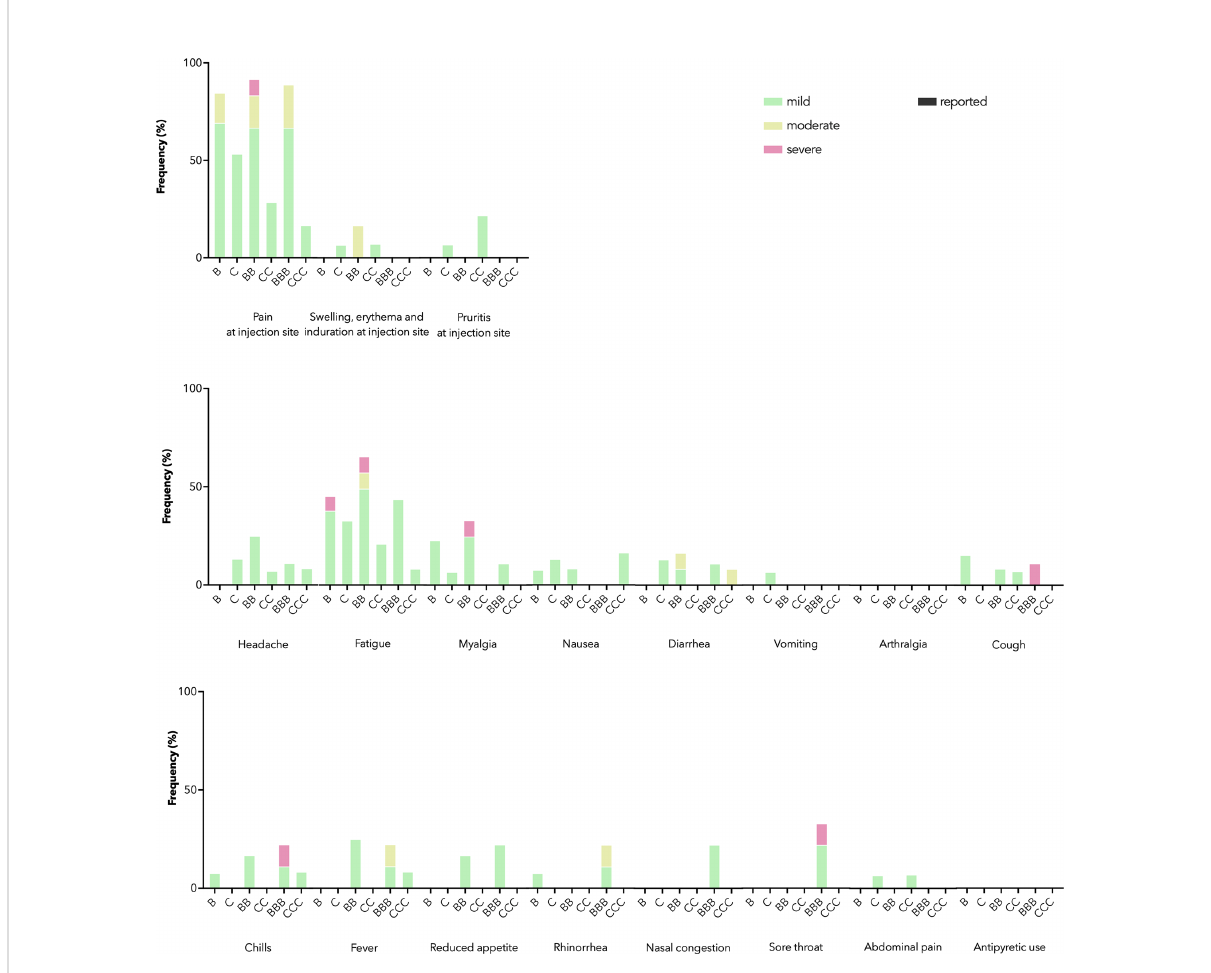
FIGURE 1 Adverse reactions (ARs) and antipyretic use reported 7 days after each dose by vaccine brand. B, BB, and BBB refer to 1, 2, and 3 doses of BNT162b2 while C, CC, and CCC refer to 1, 2, and 3 doses of CoronaVac. Stacked bar chart shows ARs by maximal severity in different colors. Severity was self-graded by participants, according to whether the AR affected daily activity (mild – tolerable, not affecting daily activities, moderate - performance of some daily activities affected, or severe - performance of some daily activities prevented), or for swelling, erythema and induration at injection site, the diameter affected (mild – 2-5 cm, moderate – 5-10 cm, severe – above 10 cm), or for fever, the body temperature (mild – 38.0-38.4°C, moderate – 38.5-38.9°C, severe – 39.0 °C or